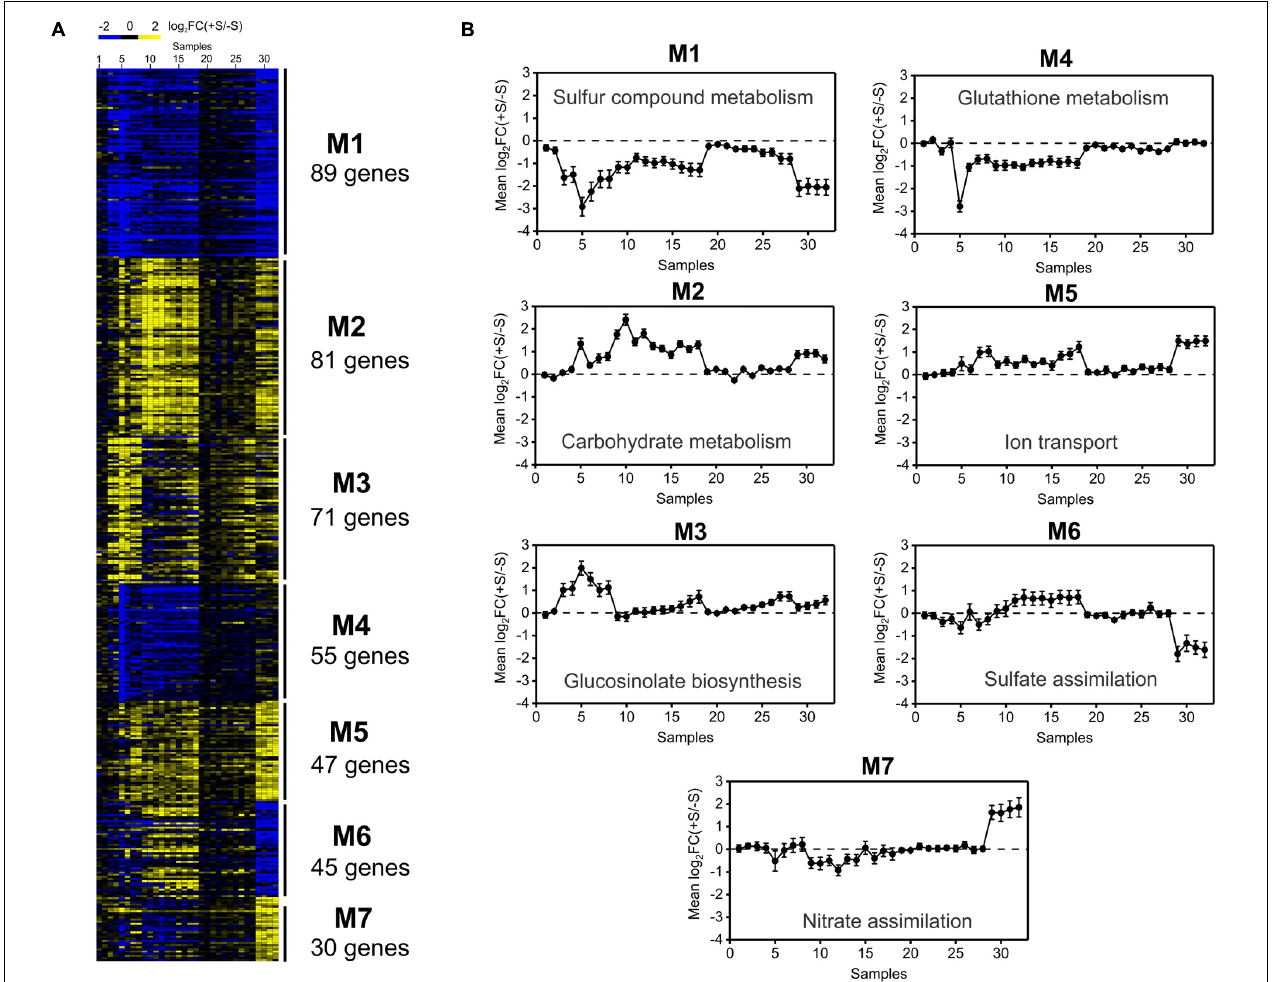
FIGURE 4 | Hierarchical clustering of transcriptomic data from sulfate-availability experiments uncovers functional modules involved in the sulfate response. (A) Heatmap of 418 sulfate-responsive genes selected in the meta-analysis. Gene co-expression modules identified using Dynamic Tree Cut software are indicated on the right-hand side of the heatmap. Genes up-regulated by sulfate are indicated in yellow, and genes down-regulated by sulfate are shown in blue. (B) Average expression profiling of each co-expression module across the different samples analyzed in the meta-analysis. Samples 1 to 6 correspond to the experiment of Bielecka et al. (2015), samples 7 and 8 correspond to the experiment of Aarabi et al. (2016), samples 9 to 18 correspond to the dataset of Iyer-Pascuzzi et al. (2011), samples 19 to 28 correspond to the dataset of Maruyama-Nakashita et al. (2005) and samples 29 to 32 correspond to the experiment of Forieri et al. (2017). The GEO accession number for each sample is indicated in Supplementary Table S4 . The most over-represented GO term for the biological processes is indicated within each